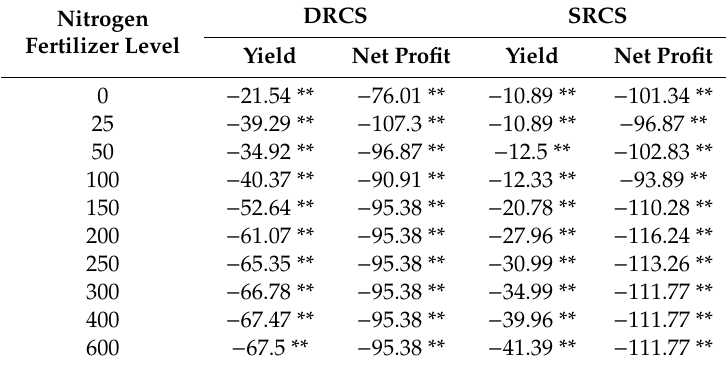
Table 4. The temporal tendency in rice grain yield (kg ha − 1 y − 1 ) and net profit ($ ha − 1 y − 1 ) for DRCS and SRCS at different nitrogen fertilizer levels (kg ha − 1 ) during the growing season from 1981 to 2015.